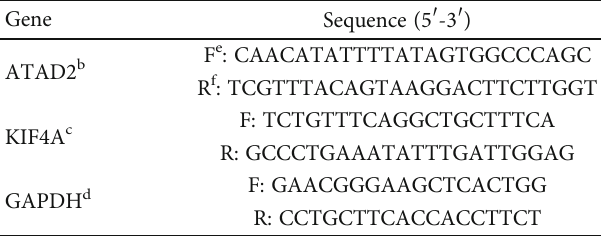
Table 1: Primer sequences for RT-qPCR a . Gene